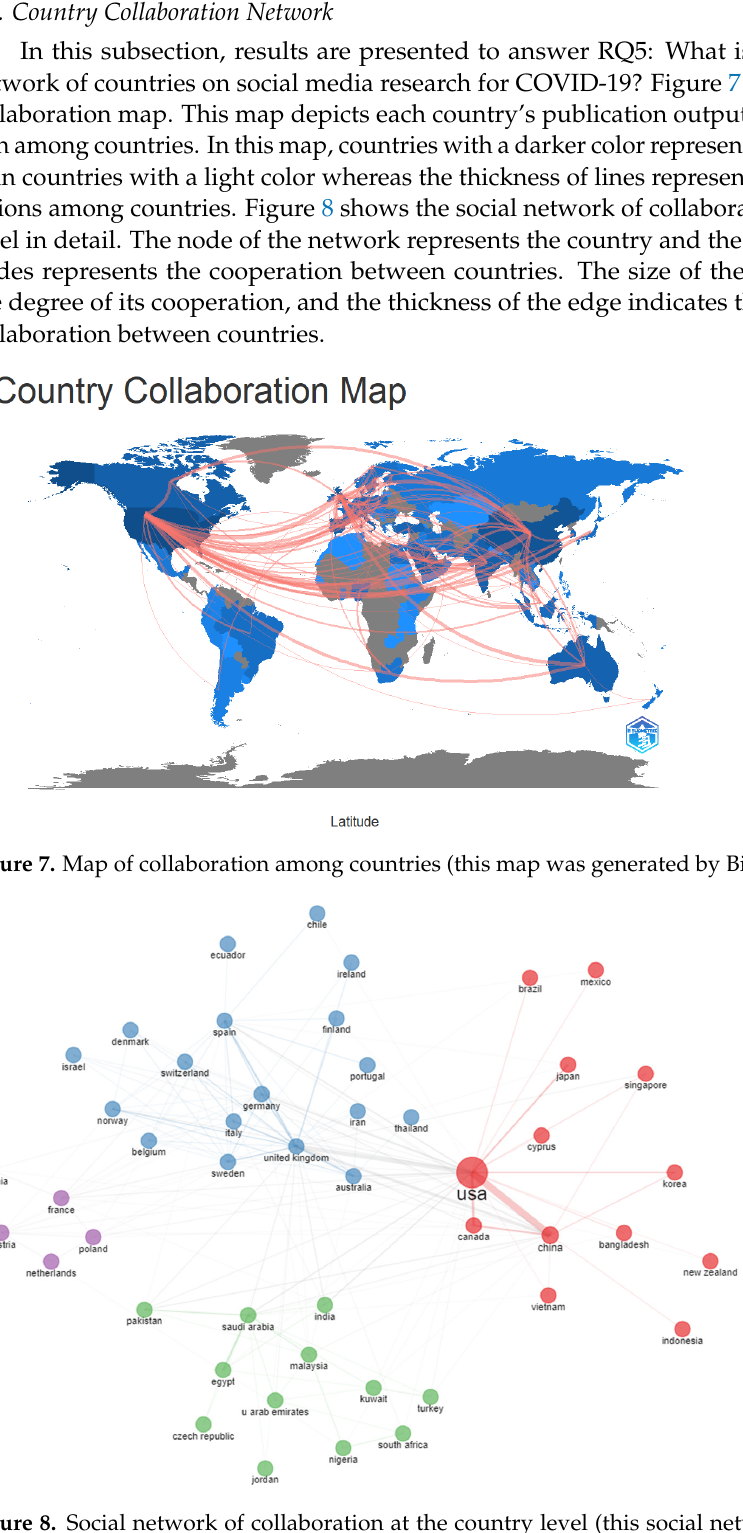
Figure 8. Social network of collaboration at the country level (this social network was generated by